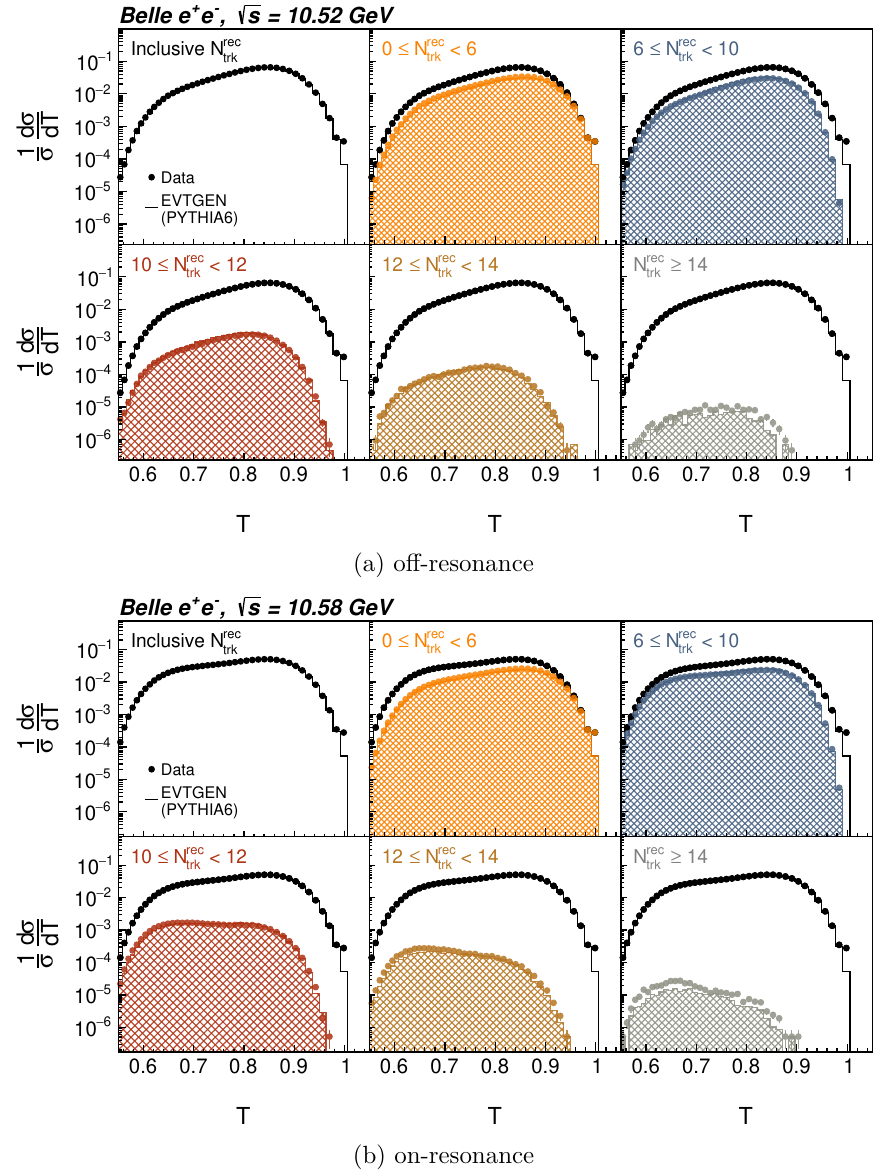
Figure 2. The thrust distributions for (a) off-resonance and (b) on-resonance samples using the same partial samples as figure 1. Results of the data (points) and the pythia6 -based Belle MC (hatched areas) are overlaid. The multi-panel histograms show the inclusive distributions and events with N rec in [0 , 6) , [6 , 10) , [10 , 12) , [12 , 14) and [14 , ∞ ) intervals in black, gold, blue, red, brown and trk gray,